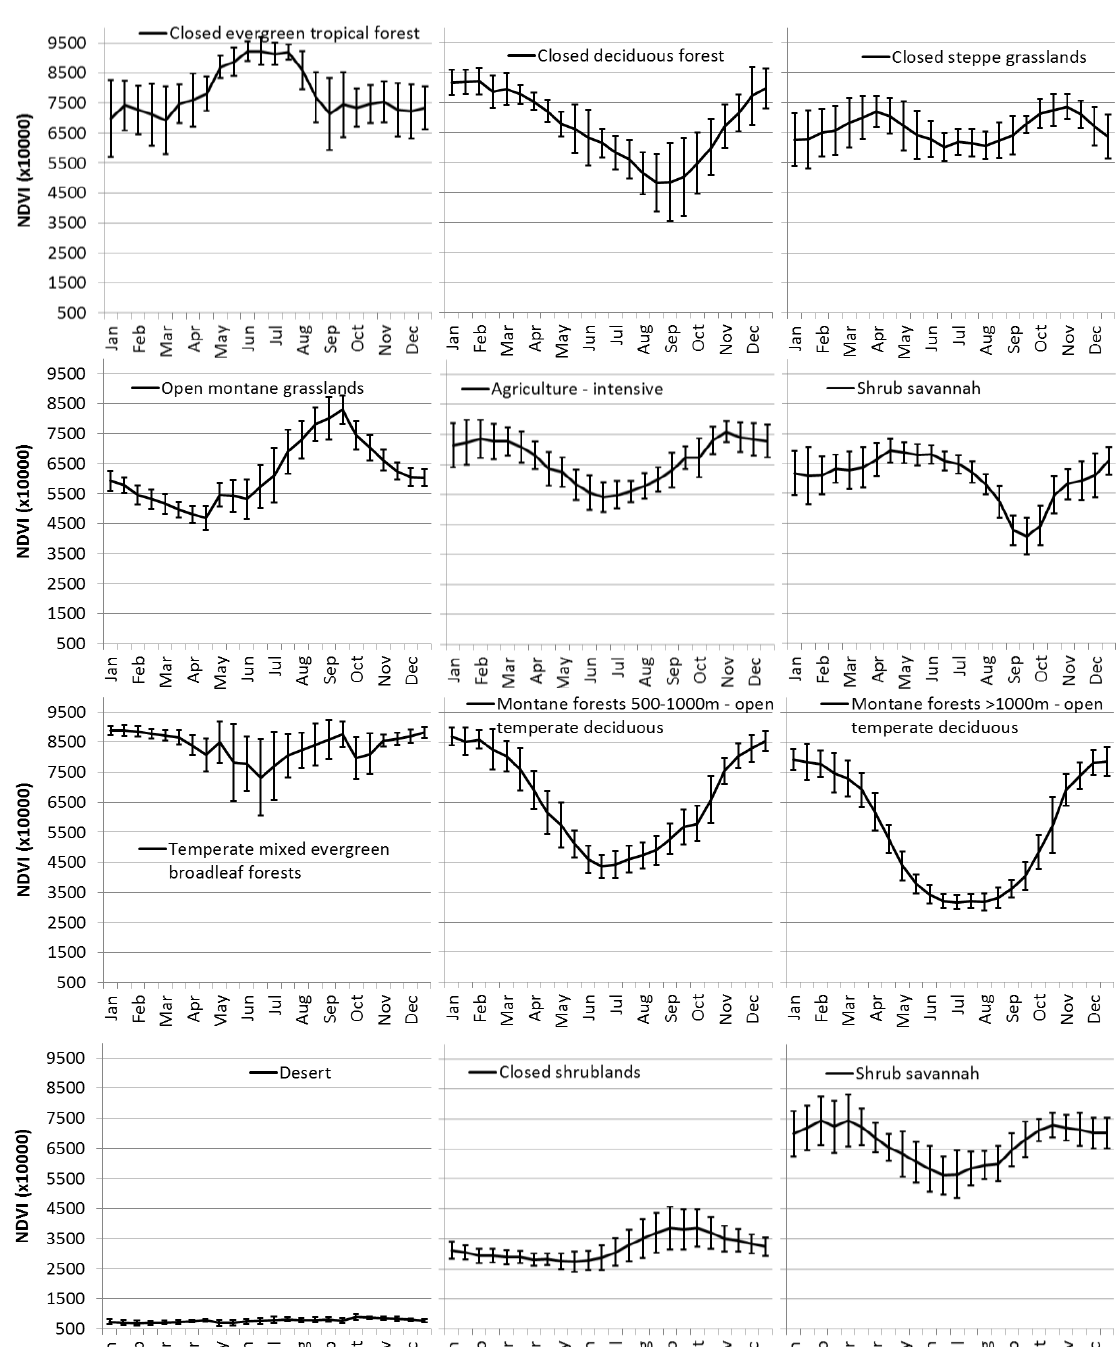
Figure 2. Seasonal NDVI response and variability for representative vegetation cover types—sample areas, 9 pixel averages, based on the mean NDVI value composite period over a 30-year period. The standard deviations (vertical bars) are indicative of the 30-year interannual